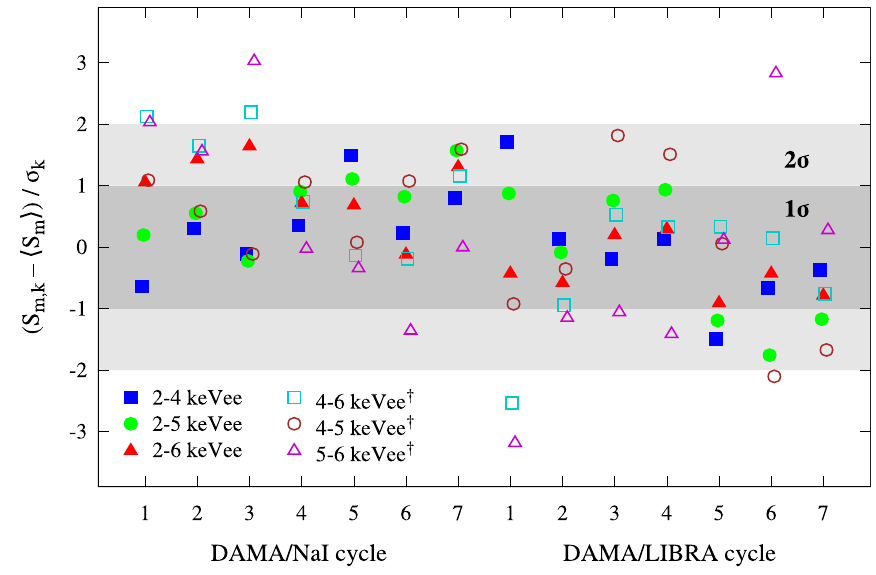
Fig. 1 The deviations of the modulation amplitude in each annual cycle for a given energy range compared to the average in that range. S m , k and σ k are the amplitude and uncertainty in the k th annual cycle, respectively, and (cid:4) S m (cid:5) is the average amplitude in the particular energy range for the